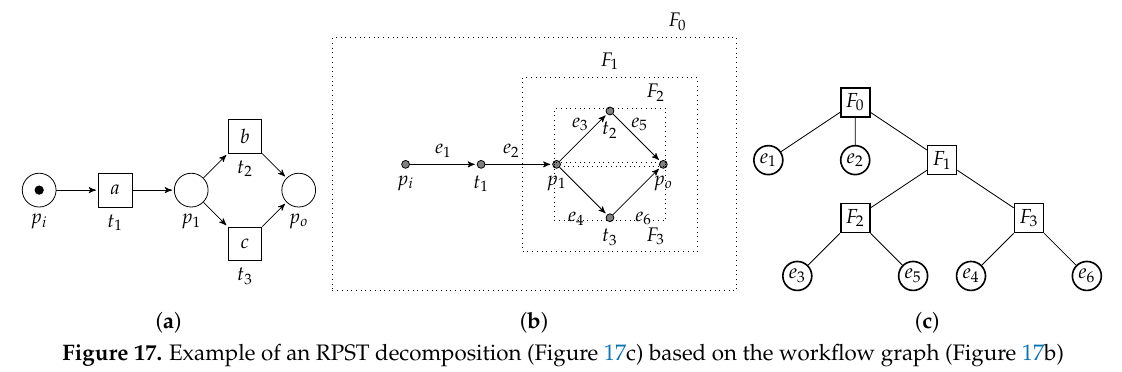
Figure 17. Example of an RPST decomposition (Figure 17c) based on the workflow graph (Figure 17b) of a simple sound WF-net W 2 (Figure 17a). ( a ) Simple WF-net W 2 . ( b ) The workflow graph of W 2 , including its canonical fragments. ( c ) The RPST of W 2 . .